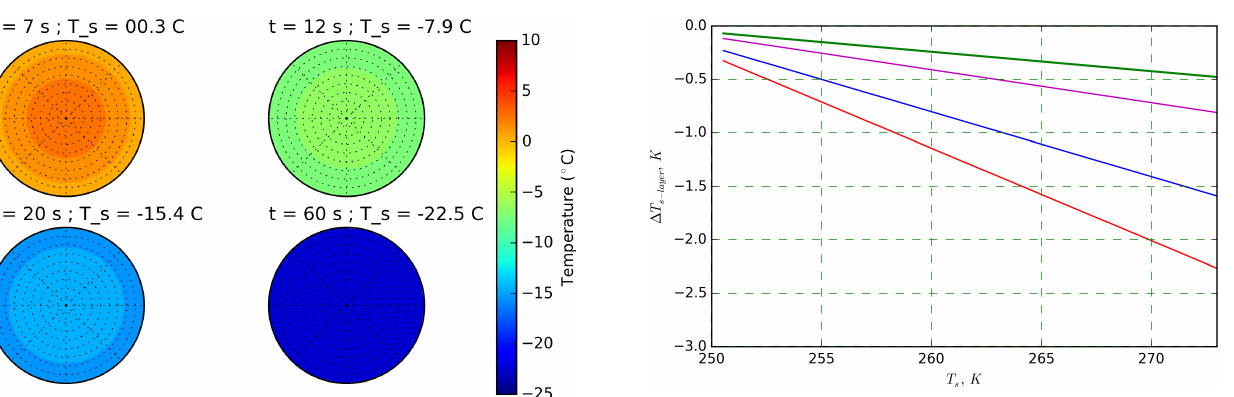
Figure B2. Internal temperatures at four different time instances for a continuously cooling drop of 2mm diameter in the M-AL follow- ing Fig. B1 based on numerical simulation of the heat conduction equation.